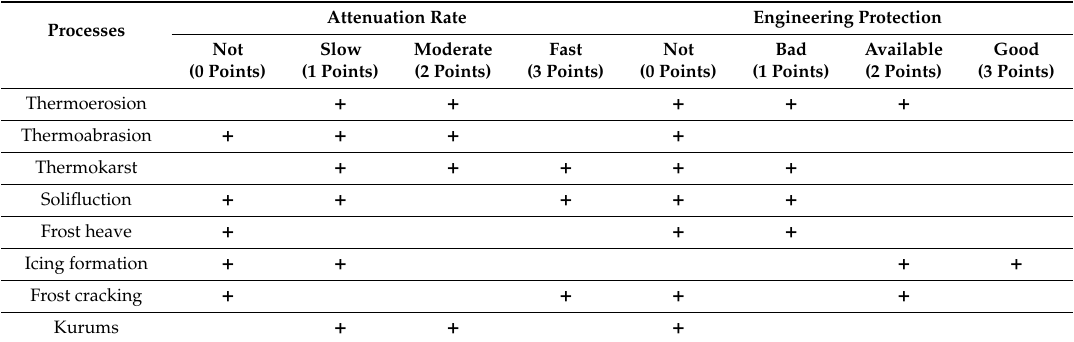
Table 5. Cryogenic processes attenuation rate and availability of engineering